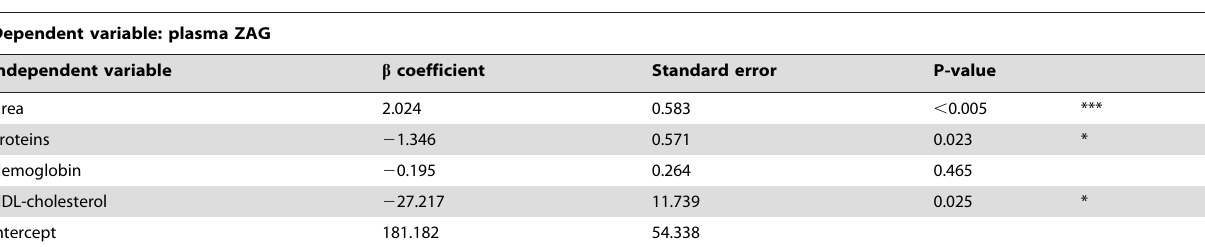
Table 4. Multiple linear regression showing association with plasma ZAG concentration (r 2 =0.406, P , 0.001).